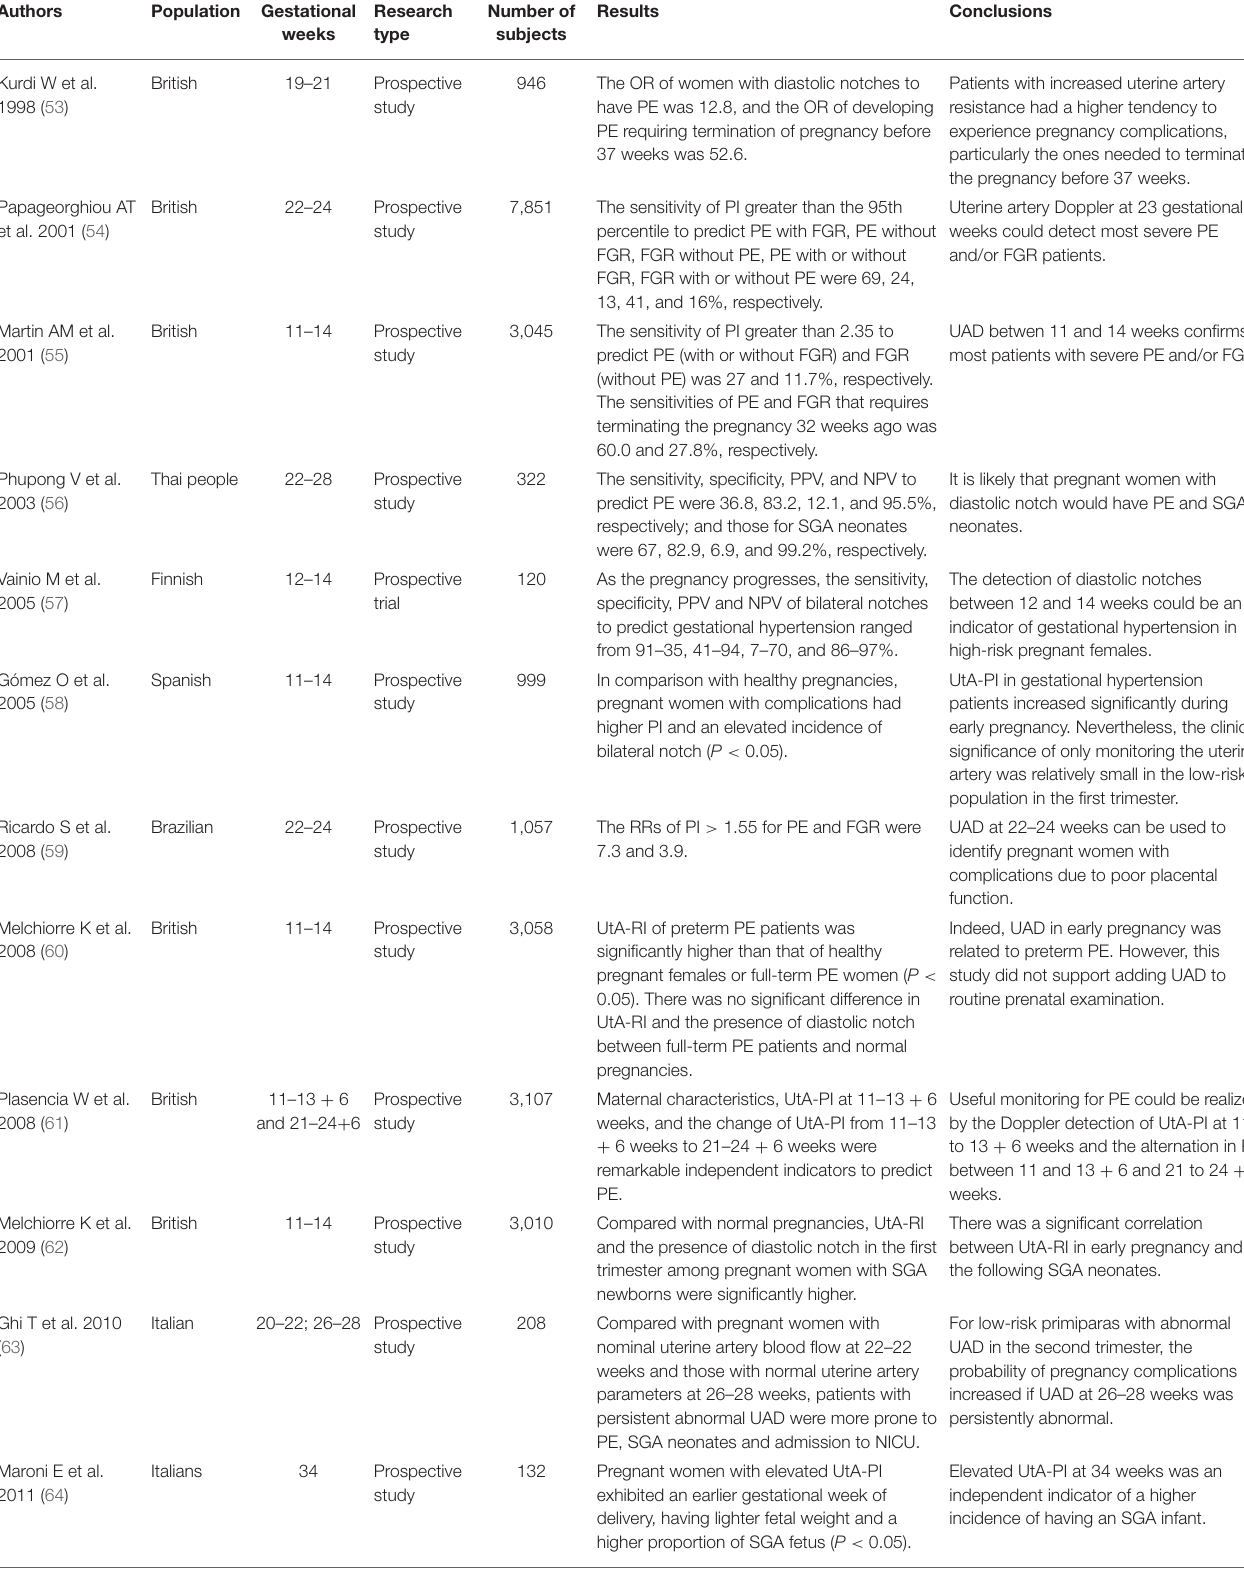
TABLE 2 | Studies on uterine artery Doppler (UAD) in preeclampsia (PE) and fetal growth restriction (FGR).